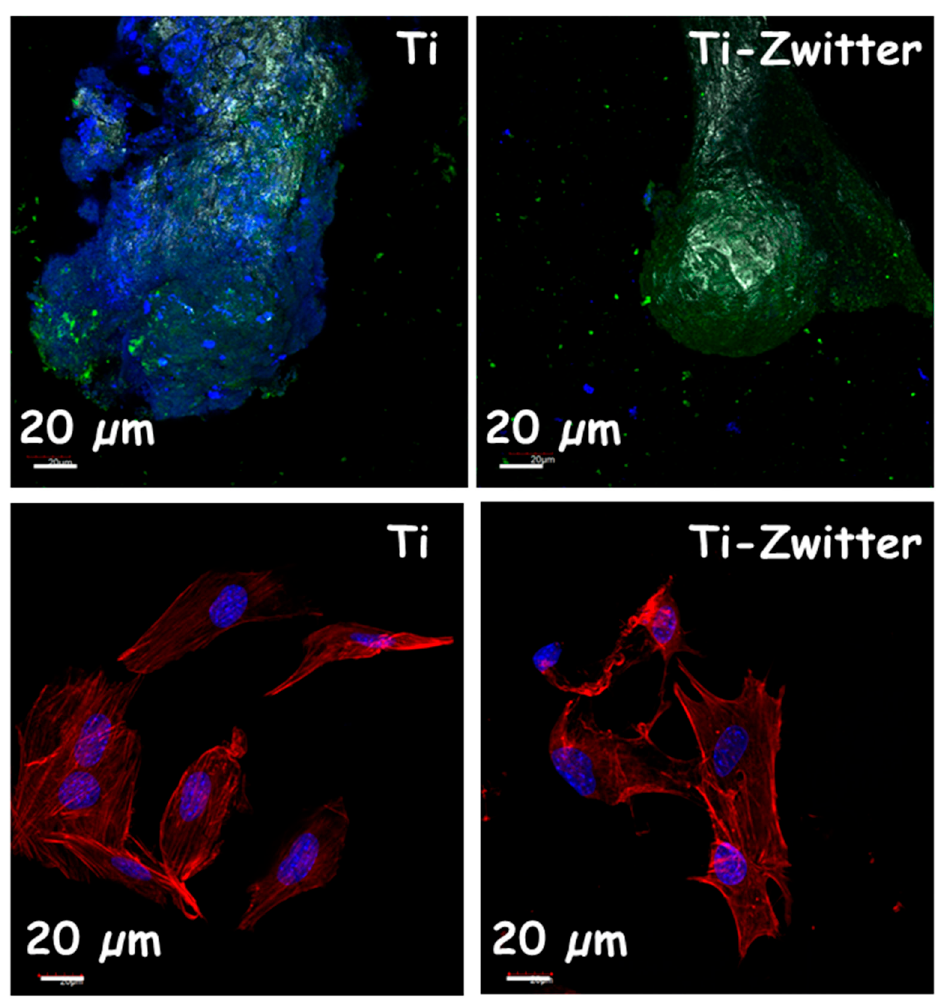
Figure 5. Confocal microscopy images showing of EBM-Ti6Al4V 3D scaffolds before (Ti) and after being zwitterionized (Ti-Zwitter). In vitro behavior of the biomaterials after being incubated during 24 h in S. aureus bacteria (Top) and during 4 days in MC3T3-E1 preosteoblast cells (Bottom). The results reveal the biofilm formation on the Ti surface, appearing the blue coating corresponding to the polysaccharide matrix (calcofluor), whereas this coating is not observed on the surface of Ti-zwitter surface, which confirms the antibiofilm formation preventing capability of this material. Both Ti and Ti-zwitter surfaces undergo an appropriate preosteoblastic colonization and spreading in the entire surface, with the nuclei stained in blue (DAPI) and the cytoskeleton stained in red (phalloidin).